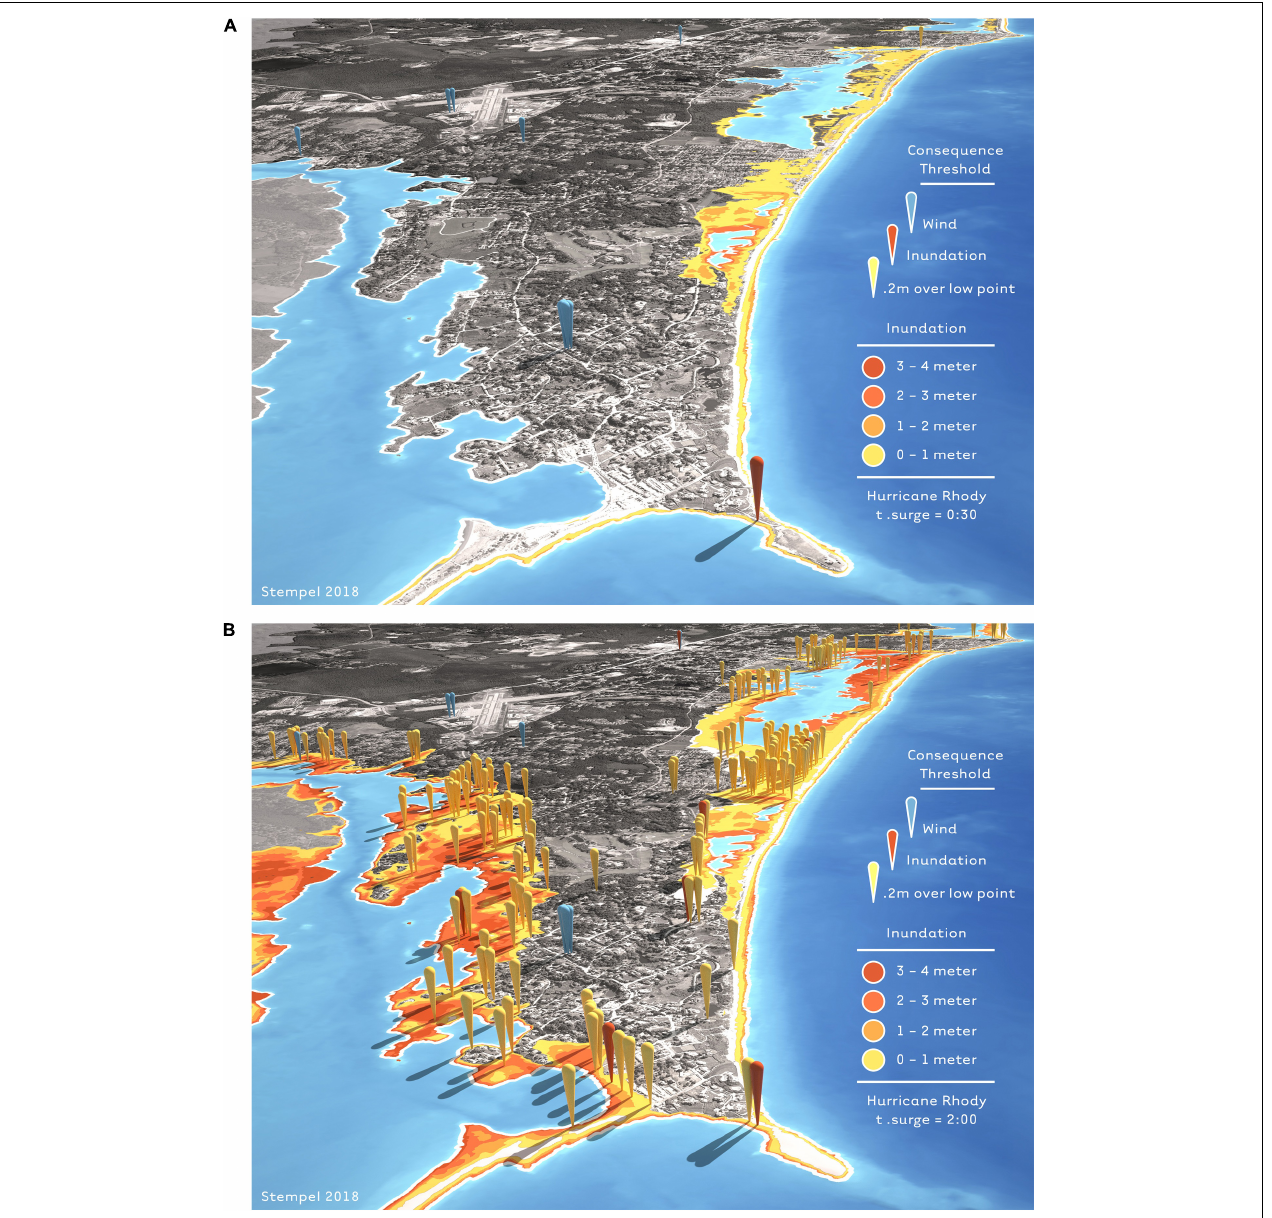
FIGURE 5 | Storm impact model for Westerly’s critical facilities showing wind and inundation CTs triggered by hypothetical Hurricane Rhody 30 min (A) and 2 h (B) after Rhody’s landfall. The red pin in front is a CT triggered by one foot of flooding and represents a fire chief’s concern that, “When it floods above a foot here, we can’t reach the homes around the lighthouse.” Yellow pins show where inundation blocks roads (Image: authors).